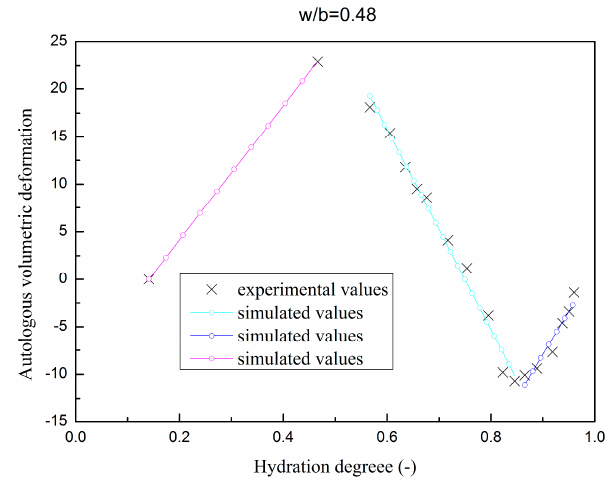
Figure 5. Autologous volumetric deformation evolution of fly ash concrete (w/b = 0.45).